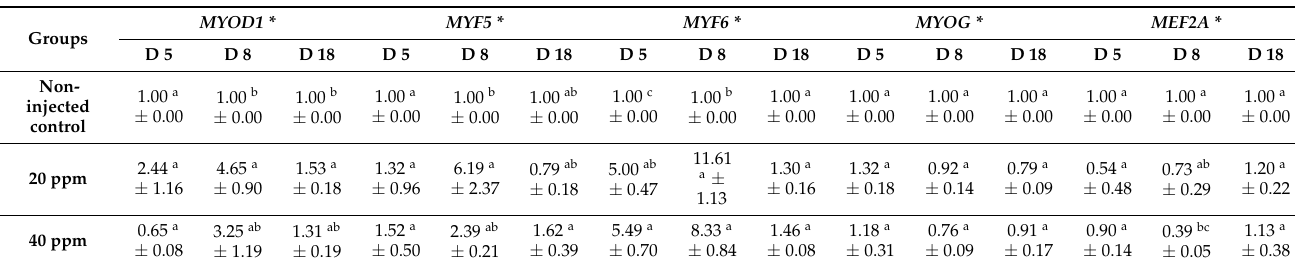
Table 2. Least square means and their standard errors for the effect of Nano-Ag treatment (20 and 40 ppm) on the expression of myogenic determination factor 1 ( MYOD1 ), myogenic factor 5 ( MYF5 ), myogenic factor 6 ( MYF6 ), myogenin ( MYOG ), and myocyte enhancer factor 2A ( MEF2A ) on days (D) 5, 8, and 18 of incubation. The expression is presented in fold change compared with the non-injected control, ( n = 3, from each group).